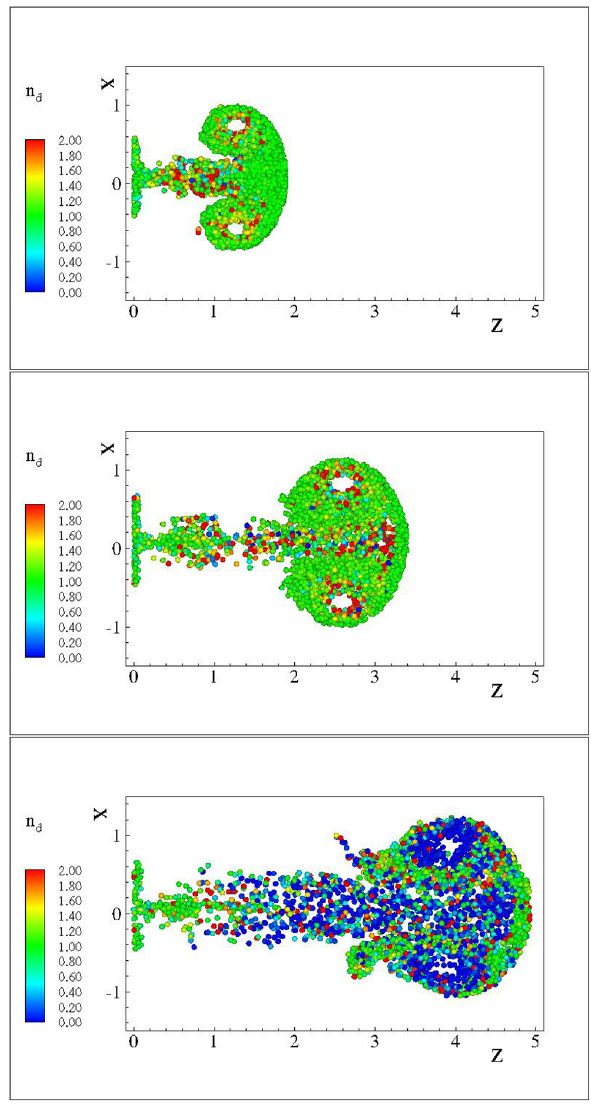
3 s (top) 3 s equal to twice the injection period